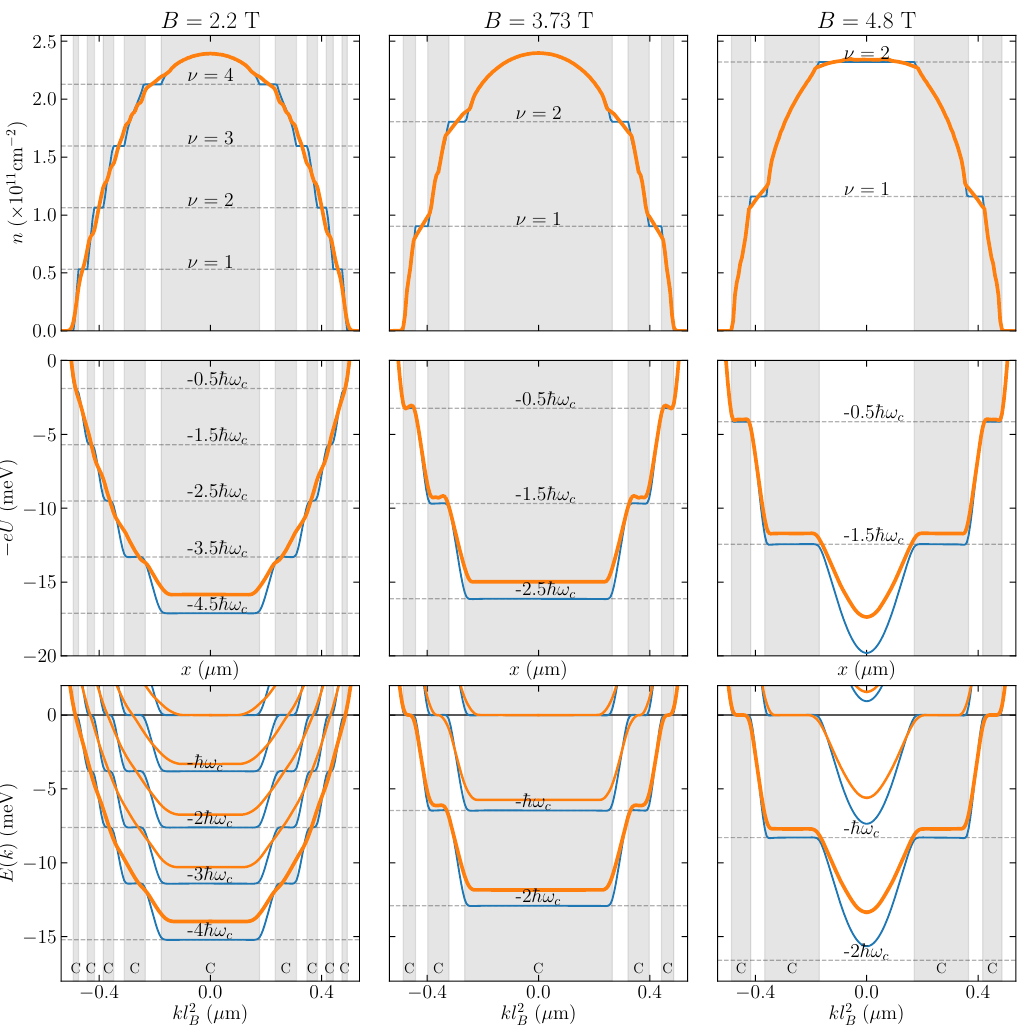
Figure 9: Density (top), potential (middle) and band structure (bottom) for different magnetic fields (from left to right B = 2.2,3.73,4.8T) for the geometry of Fig. 1(b). Thomas-Fermi approximation is shown in blue lines while the Full self-consistent (FSC) result is shown in thicker orange lines. The horizontal lines indicate the integer filling factors ν ( n = ν eB / h ) and the multiple of the cyclotron frequency ω Gray and white regions indicate the compressible and incompressible stripes, respec-